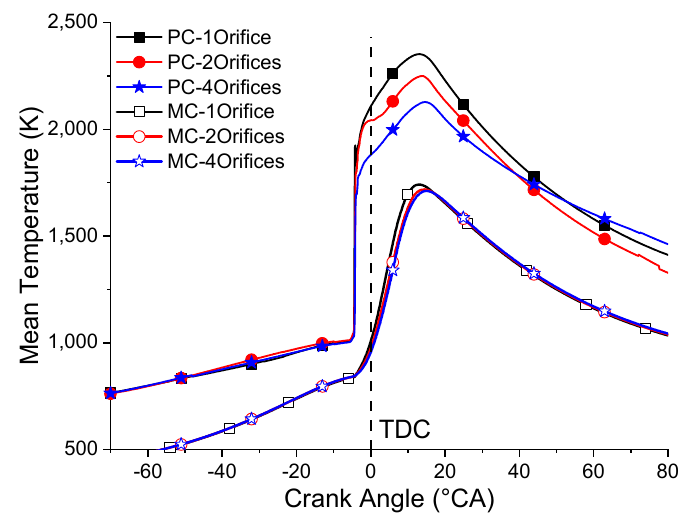
Figure 10. Mean in-cylinder temperature with different injector orifices.